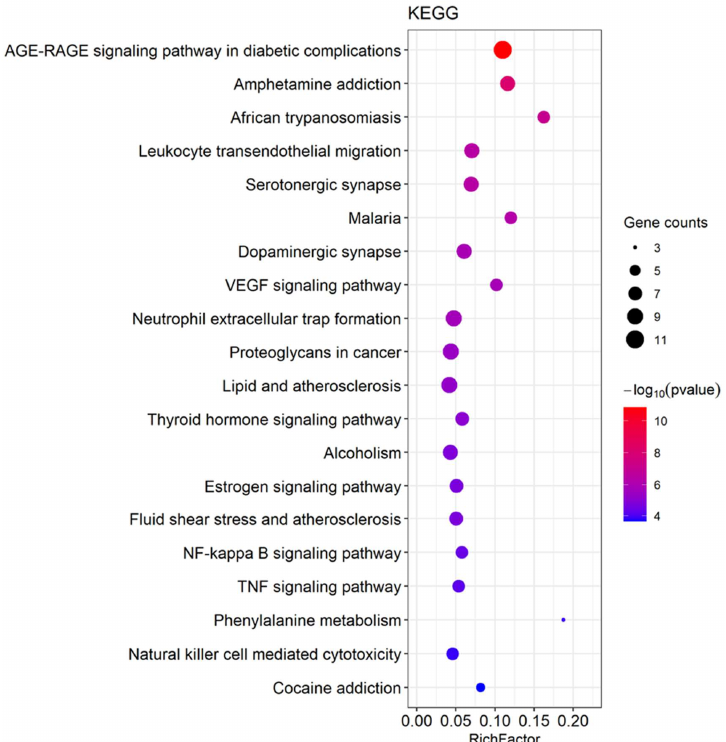
Figure 6. Kyoto Encyclopedia of Genes and Genomes (KEGG) enrichment analysis showing the top 20 of p- coumaric acid (p-CA)-mediated signaling pathways.